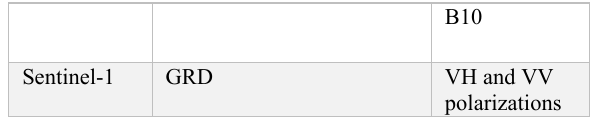
Table 2: Bands and processing level of satellite datasets